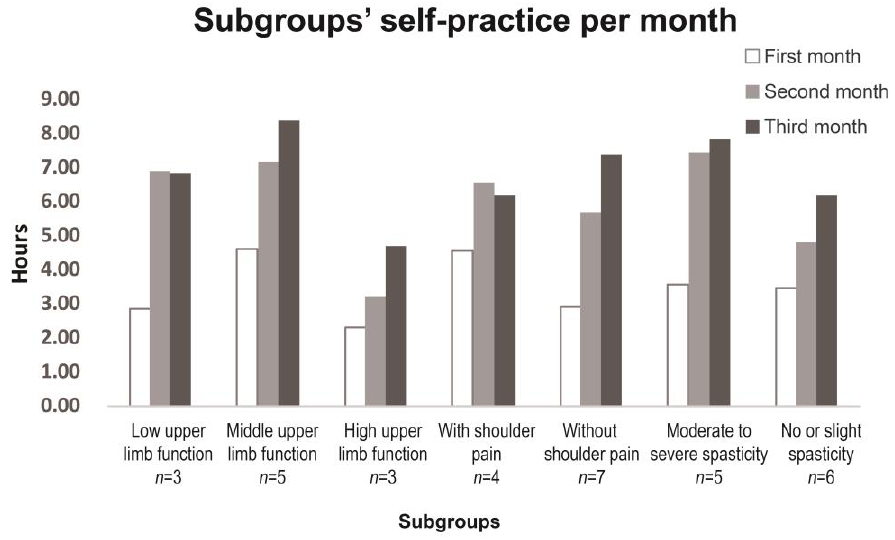
Figure 4. Subgroups’ self-practice hours per month for participants.